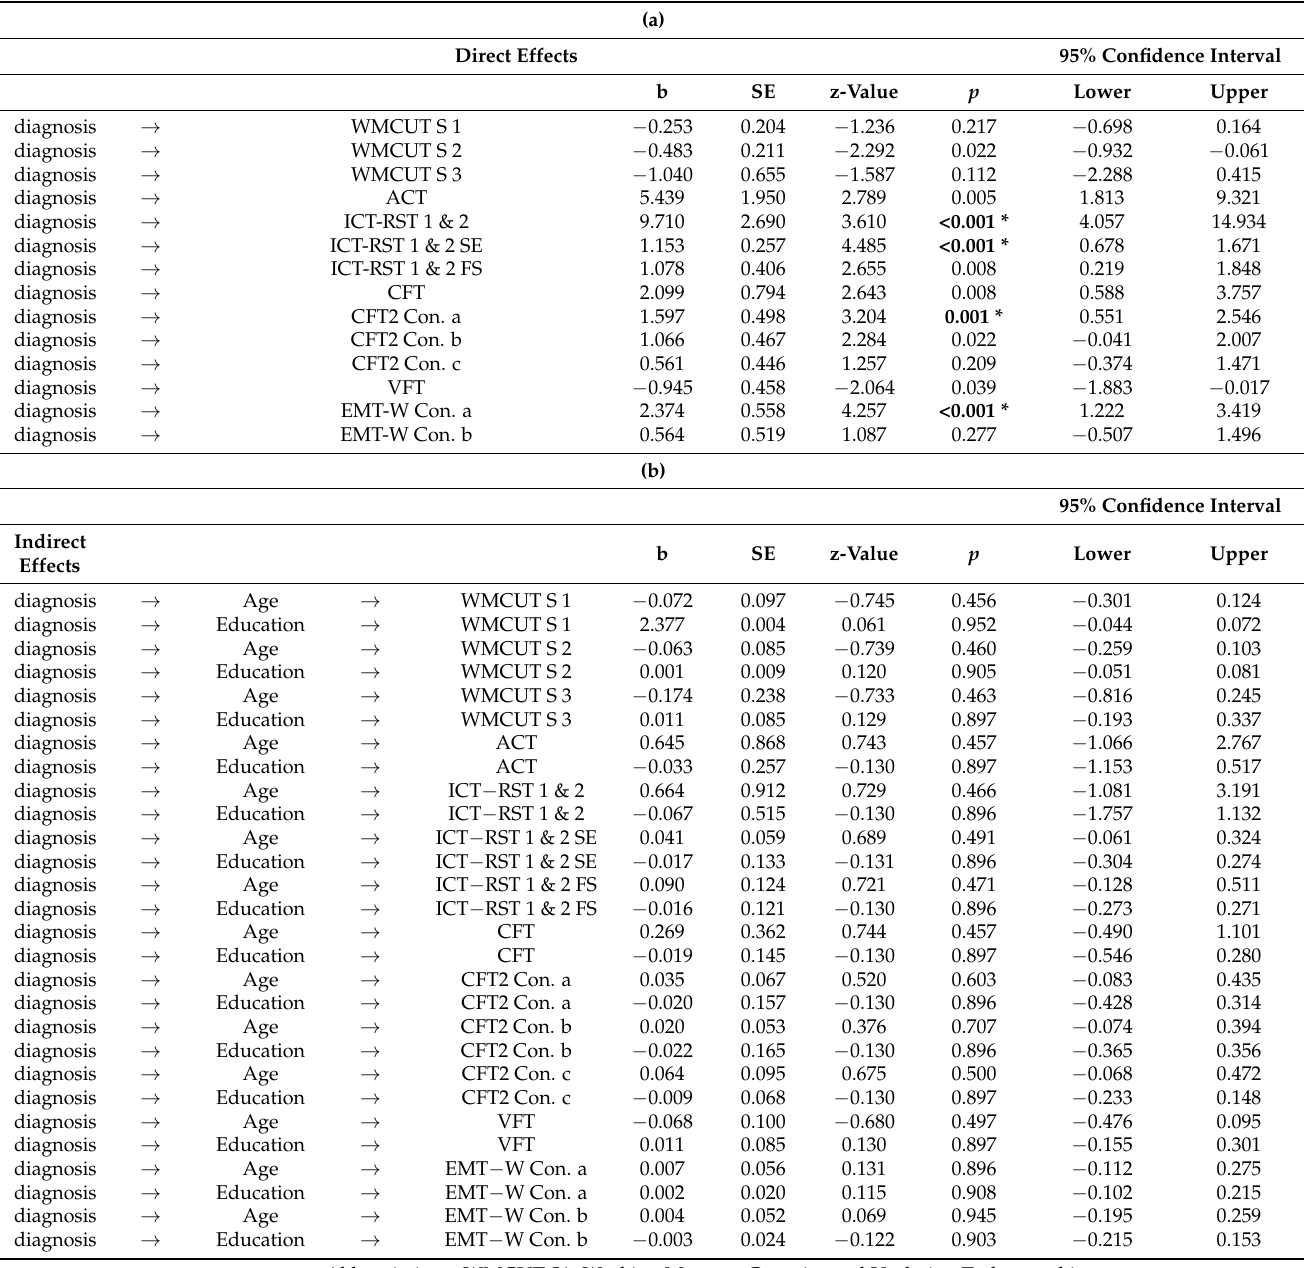
Table 3. ( a ) Direct effects of diagnosis on the R4Alz-R tasks and subtasks’ performance according to Mediation Analysis, between the groups of SCD and MCI (* p < 0.004) ( b ) Indirect effects of diagnosis—via age and education—on the R4Alz-R tasks’ and subtasks’ performance according to Mediation Analysis, between the groups of SCD and MCI (* p <